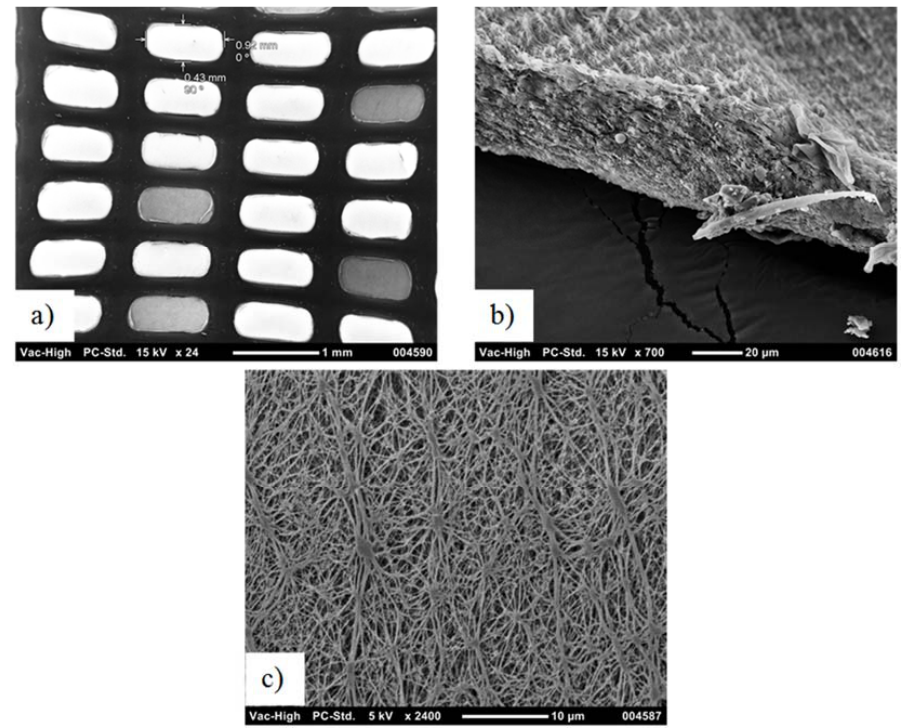
Figure 2. Standard polytetrafluoroethylene (PTFE) membrane: ( a ) scrim support (backing); ( b ) membrane side view; and ( c ) membrane front view.